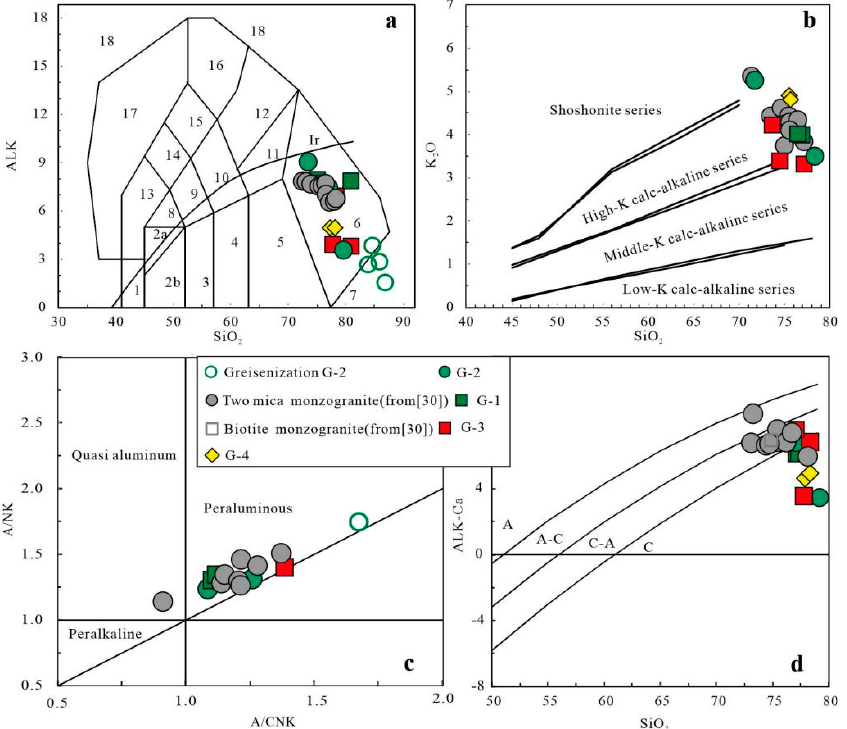
Figure 9. Major elements diagrams of granitoids from Chuankou ore field. ( a ) ALK (ALK = Na 2 O + K 2 O) versus SiO 2 diagrams, ( b ) K 2 O versus SiO 2 diagrams, ( c ) A/NK versus A/CNK diagrams, ( d ) ALK-Ca versus SiO 2 diagrams.